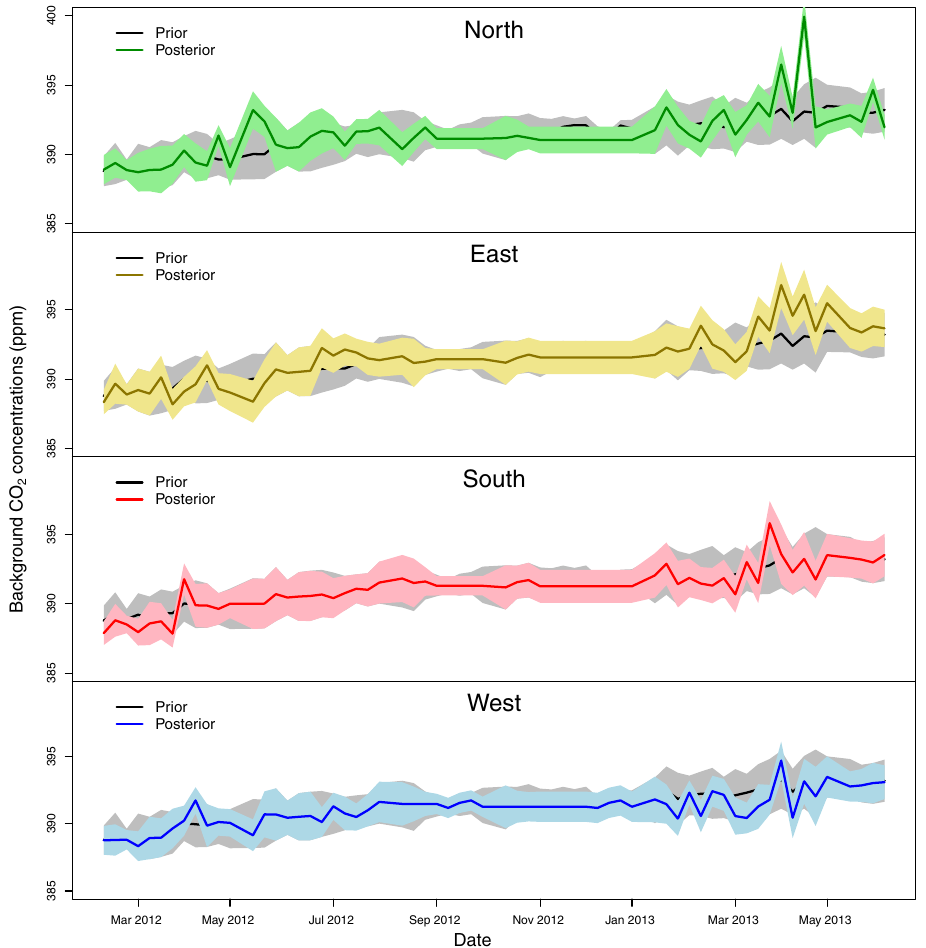
Figure 11. Time series with 95% confidence interval (represented by the shaded area) of the prior (black line) and posterior estimates of the CO 2 concentrations (ppm) at the domain boundaries (north – green, east – yellow, south – red, west – blue). The prior estimates are the same for each cardinal direction and are obtained from the Cape Point percentile-filtered observations. The posterior estimates for the concentrations are solved for as additional unknowns in the reference